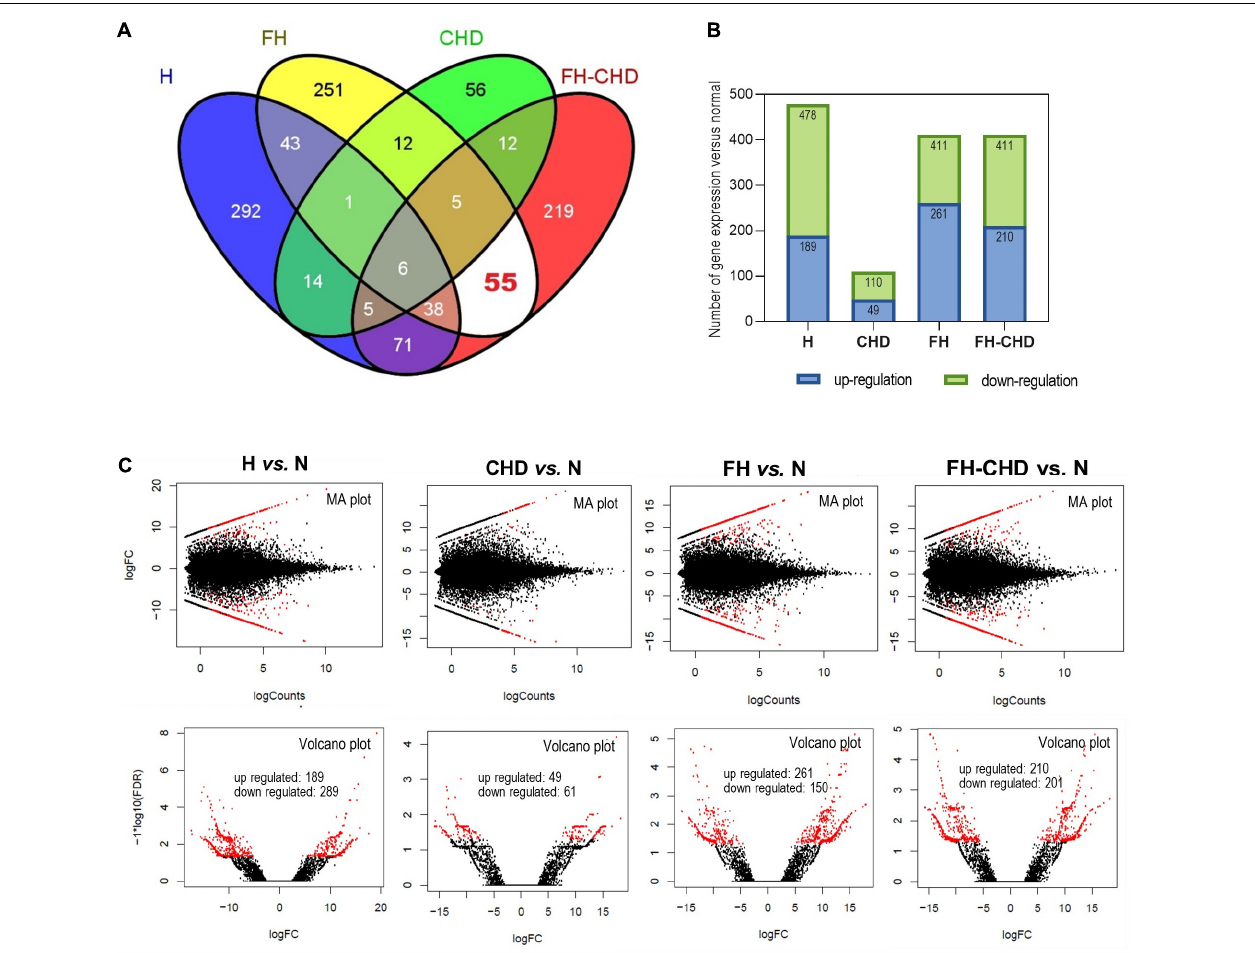
FIGURE 2 | Transcriptome analysis by next-generation sequencing in four patient groups, hyperlipidemia (H), familial hyperlipidemia (FH), coronary heart disease (CHD), and familial CHD (FH-CHD) compared with healthy volunteers (N). Total RNA was extracted from blood ( n = 3). Differentially expressed genes were performed using edgeR program via Cuffdiff 2.0 (fold change ≥ 1), p -value ≤ 0.05 and false discovery rate (FDR) ≤ 0.05. (A) Venn diagram illustrates all 1,080 differentially expressed genes, and (B) number of up- and downregulated genes expressed in the four patient groups compared with N. [ (C) , upper panels] MA plots for differential expression analysis in H, CHD, FH, or FH-CHD versus N samples. The y - and x -axes represent the log fold change (FC) of gene expression and log number of genes, respectively. The red and black points in the plot indicate significant and not significant differentially expressed genes, respectively. [ (C) , lower panels] Volcano plots of differentially expressed transcripts in H, CHD, FH, or FH-CHD versus N samples. The y - and x -axes represent the FDR value and log FC of gene expression, respectively. The filter threshold is FDR < 0.0001. The red and black points in the plot represent up- and downregulated transcripts,